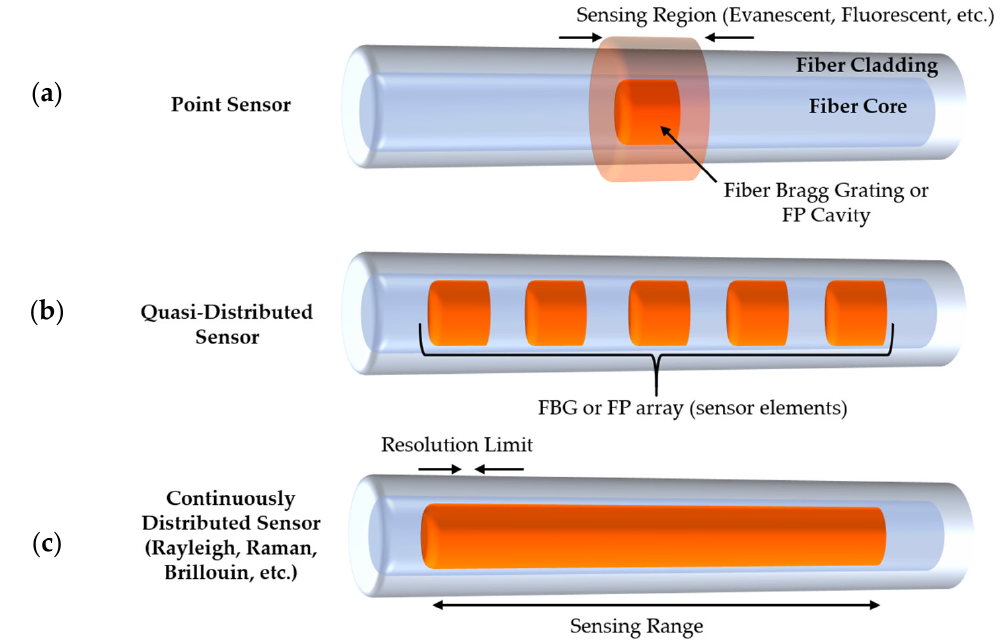
Figure 3. Schematic representation of the key components in ( a ) single-point, ( b ) quasi-distributed, and ( c ) continuously distributed fiber optic sensors.